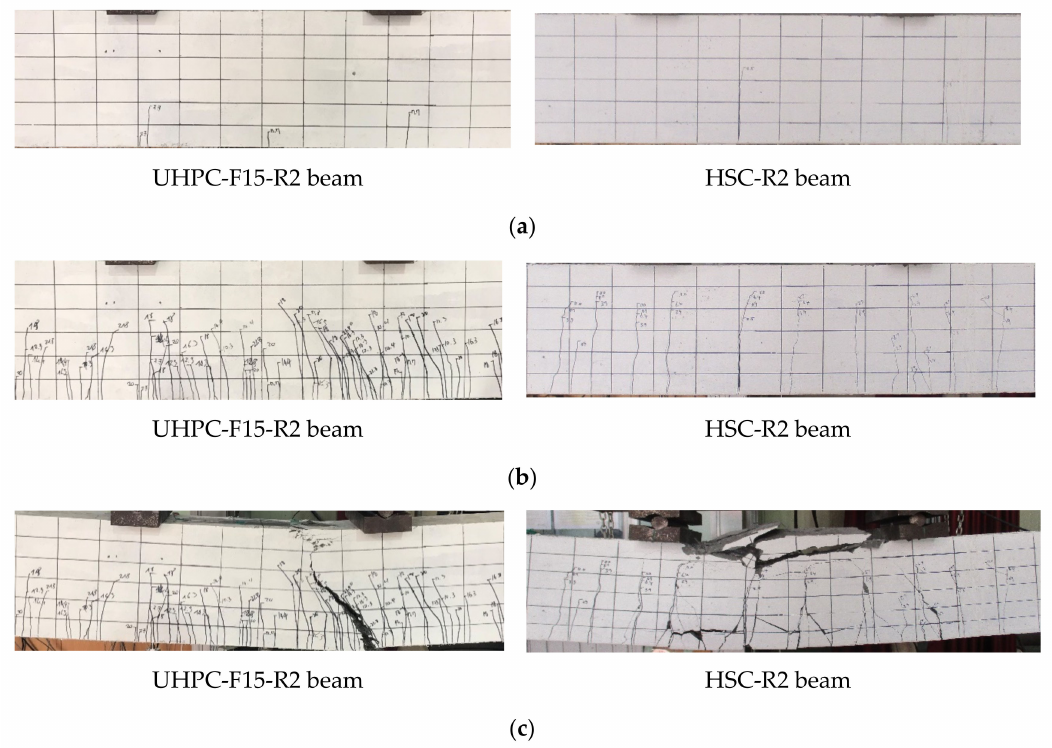
Figure 6. Typical cracking patterns of the UHPC and HSC beams. ( a ) Initial cracking state, ( b ) Yielding state, ( c ) Ultimate state.